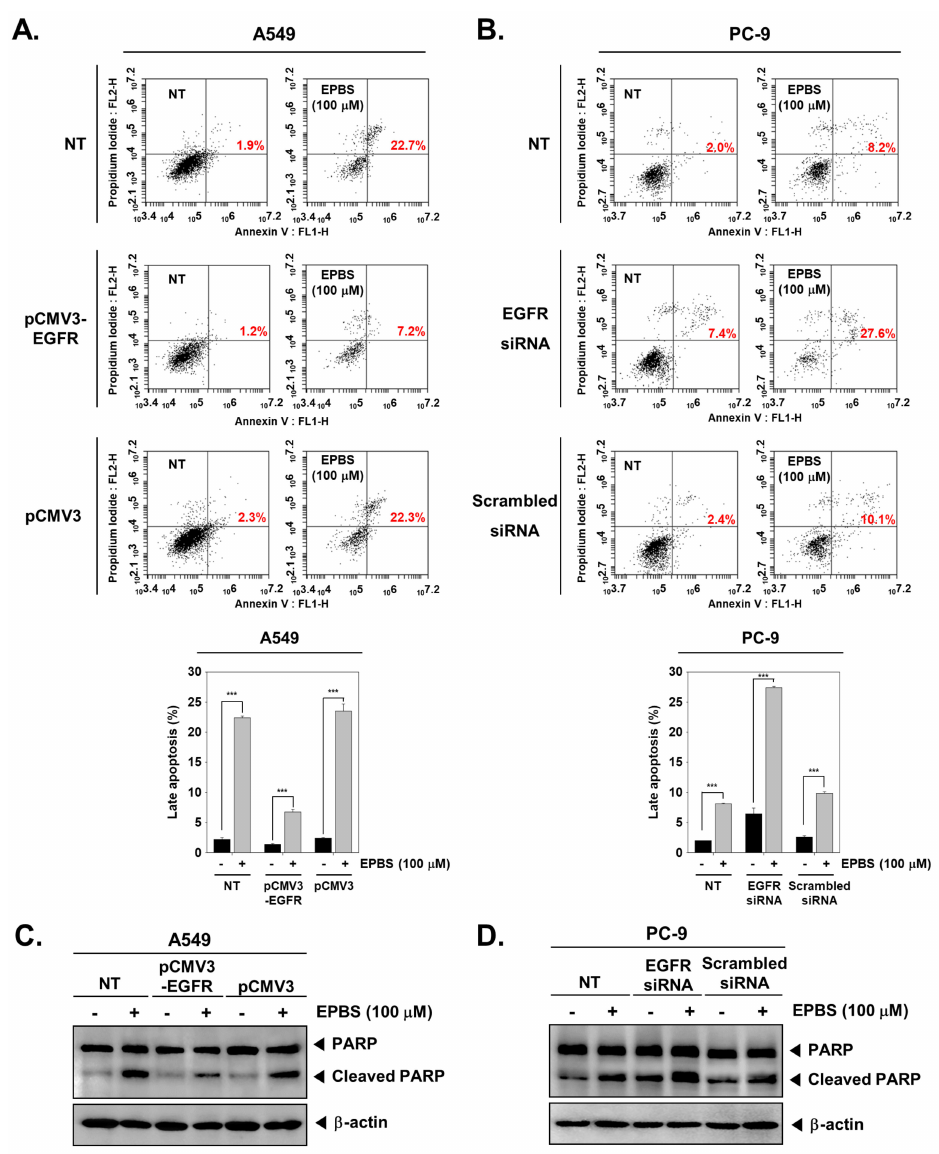
Figure 4. EPBS induces apoptosis in overexpression and knockdown of EGFR in NSCLC cells. ( A ) A total of 8 × 10 4 cells/well of A549 cells were seeded on 24-well plates overnight and then transfected with pCMV3 − EGFR or pCMV3 plasmid (300 ng) in a serum-free medium for 24 h. Then, 100 µ M of EPBS was applied for 24 h, and cells were collected. ( B ) PC-9 cells (8 × 10 4 cells/well) were transfected with EGFR siRNA or scrambled siRNA (100 nM) for 36 h. The transfected cells were treated with 100 µ M EPBS for 24 h, and then the cells were collected. Both collected cells were reacted with FITC-tagged annexin V antibodies and PI for 15 min at RT. The stained cells were analyzed by a flow cytometer. *** p < 0.001 vs. EPBS-nontreated cells. ( C ) A549 cells were transfected with pCMV3 − EGFR or pCMV3 plasmid for 24 h and then treated with 100 µ M of EPBS for 24 h. Western blot analysis was carried out. ( D ) PC-9 cells were transfected with EGFR siRNA or scrambled siRNA for 36 h. The transfected PC-9 cells were treated with 100 µ M EPBS for 24 h, and then Western blot analysis was performed for analyzing the expression of PARP protein. After at least three experiments were performed, the representative data were selected and